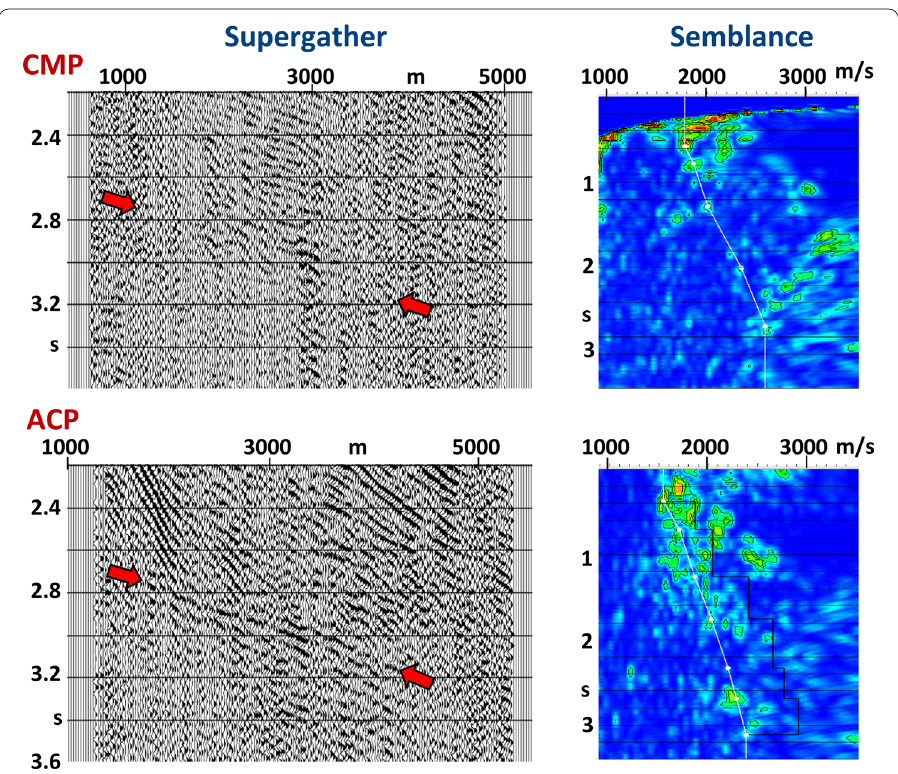
Fig. 6 Impact of binning on velocity analysis . Results of CMP- and ACP-binning using the initial v p /v s values derived from the VSP at Freiham TH-1. A CMP supergather shows almost no reflection signal in the gathered data as well as in the semblance analysis, whereas a ACP supergather delivers a visible signal, enabling further velocity analysis. See Fig. 3c for location (green star)